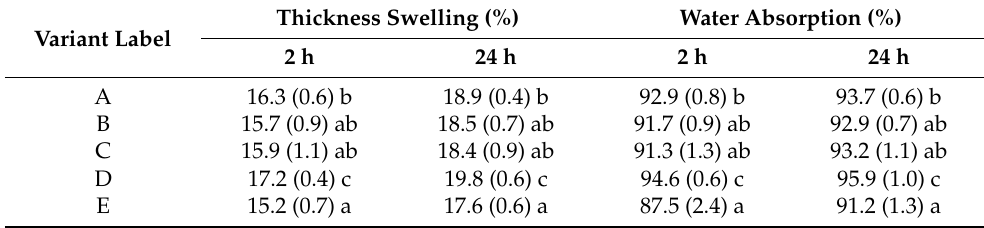
Table 4. Thickness swelling and water absorption of boards depending on the